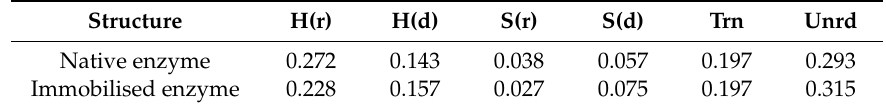
Table 1. Fractions of each type of secondary structure in lipase covalently immobilised to functionalised nanoparticle. Structure H(r) H(d) S(r) S(d) Native